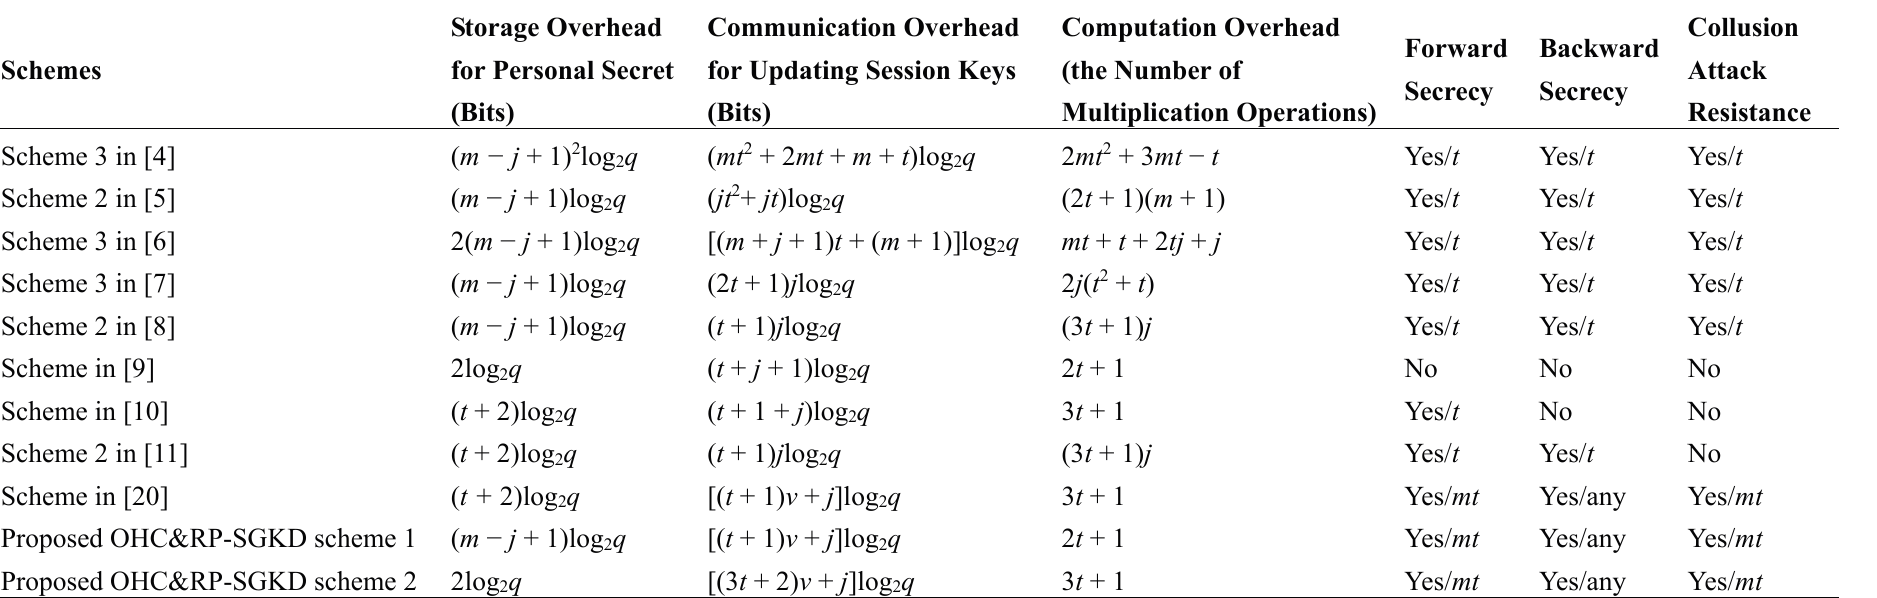
Table 1. Performance comparison